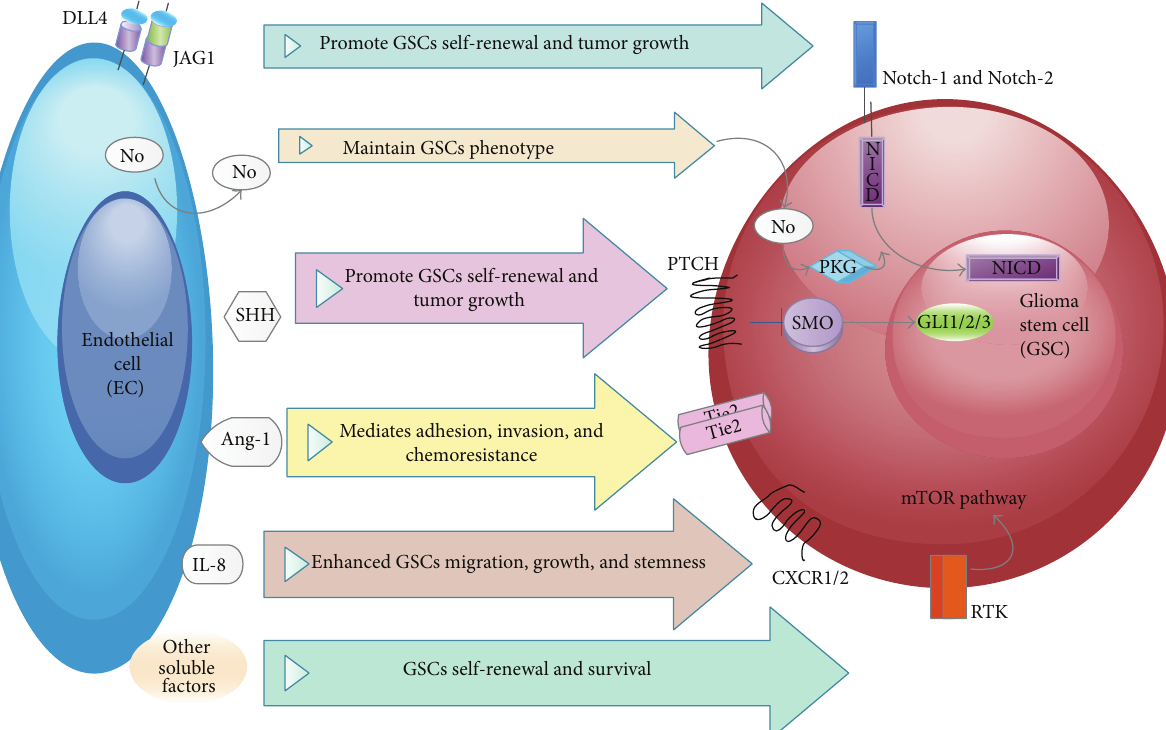
Figure 1: Effects of endothelial cells on GSCs. ECs produce membrane-bound Notch ligands Jagged-1 (JAG1) and Delta-like 4 (DLL4) that bind to Notch receptors on GSCs and promote GSCs self-renewal and tumor growth; nitric oxide (NO) that maintains GSCs phenotype; ligand sonic hedgehog (SHH) that promotes GSCs self-renewal and tumor growth; angiopoietin-1 (Ang-1) that mediates adhesion, invasion, and chemoresistance; IL-8 that enhanced GSCs migration, growth, and stemness; other soluble factors that stimulate GSCs self-renewal and